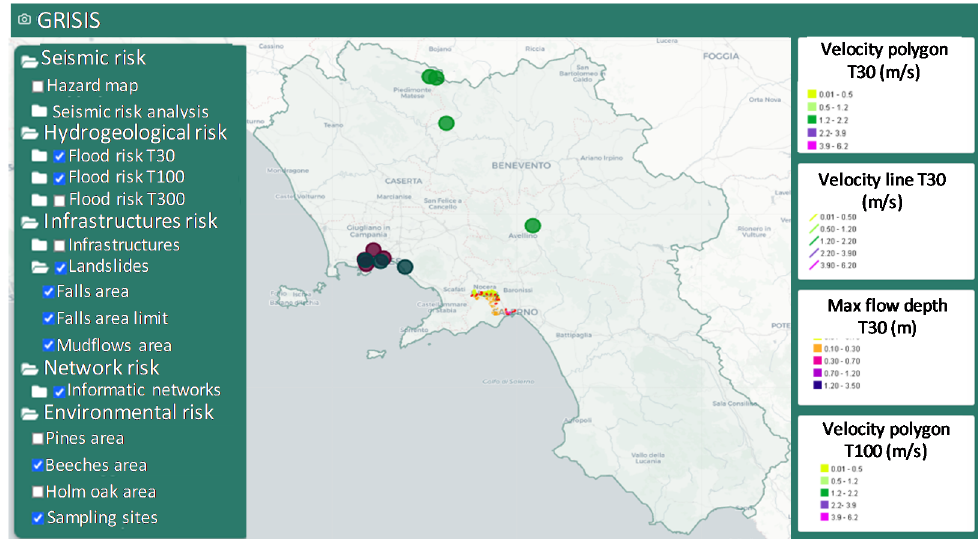
Figure 4. Platform metadata.